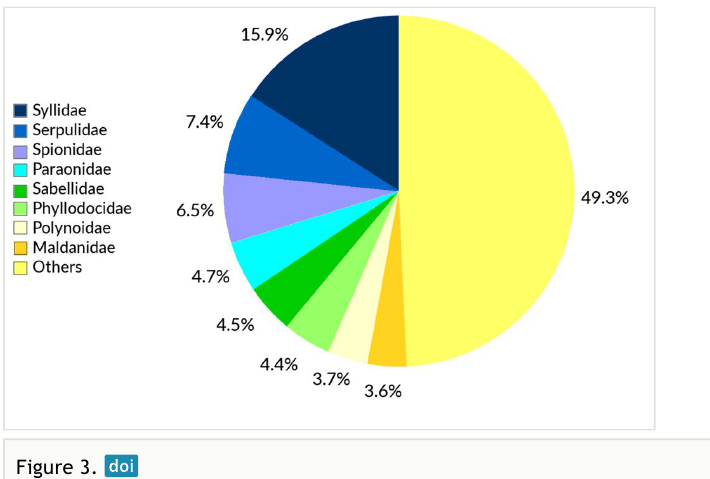
Figure 3. Percentages of species numbers of the eight most species-rich polychaete families in Greek waters compared to the remaining families.